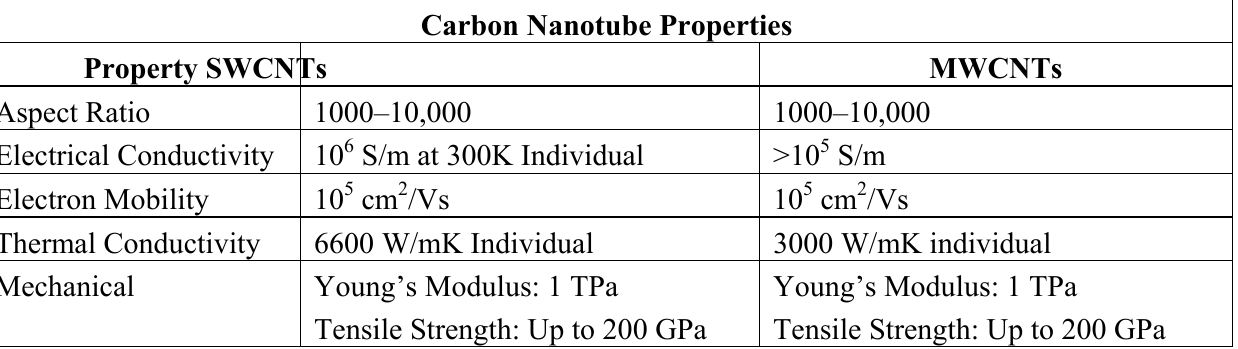
Table 1. Properties of carbon